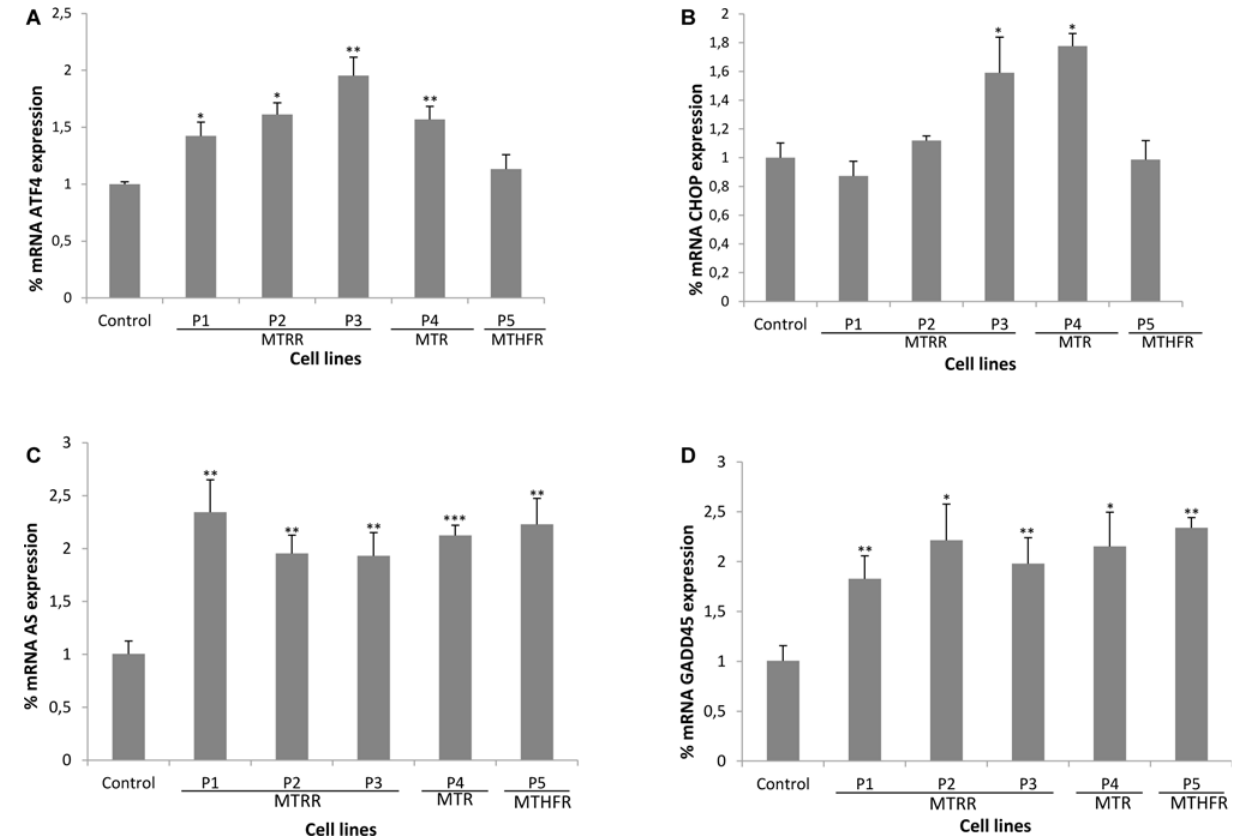
Fig 2. Quantitative gene expression analysis of ATF4, CHOP, asparagine synthase and GADD45 by qRT-PCR. (A, B, C and D) Quantities are shown relative to the expression levels of ATF4, CHOP, asparagine synthase and GADD45 mRNA in control sample. The data represent mean ± SD of three different experiments. * P < 0.05; ** P < 0.01, *** P < 0.001.